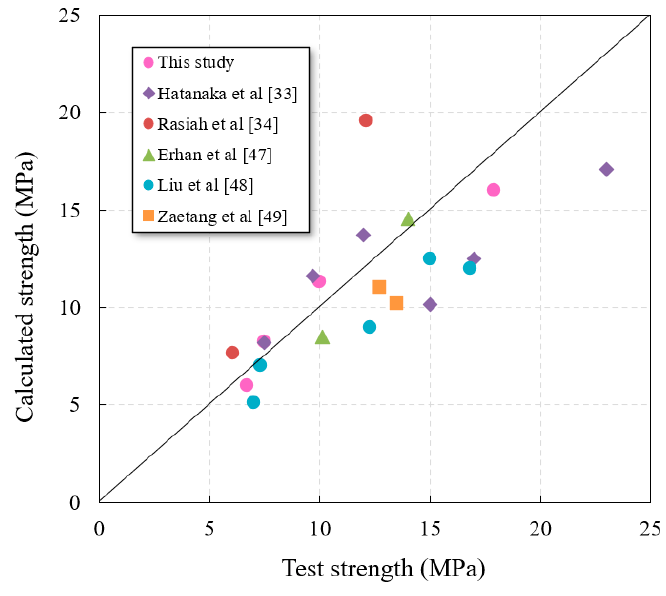
Figure 19. Relationship between calculated strength and actual strength.